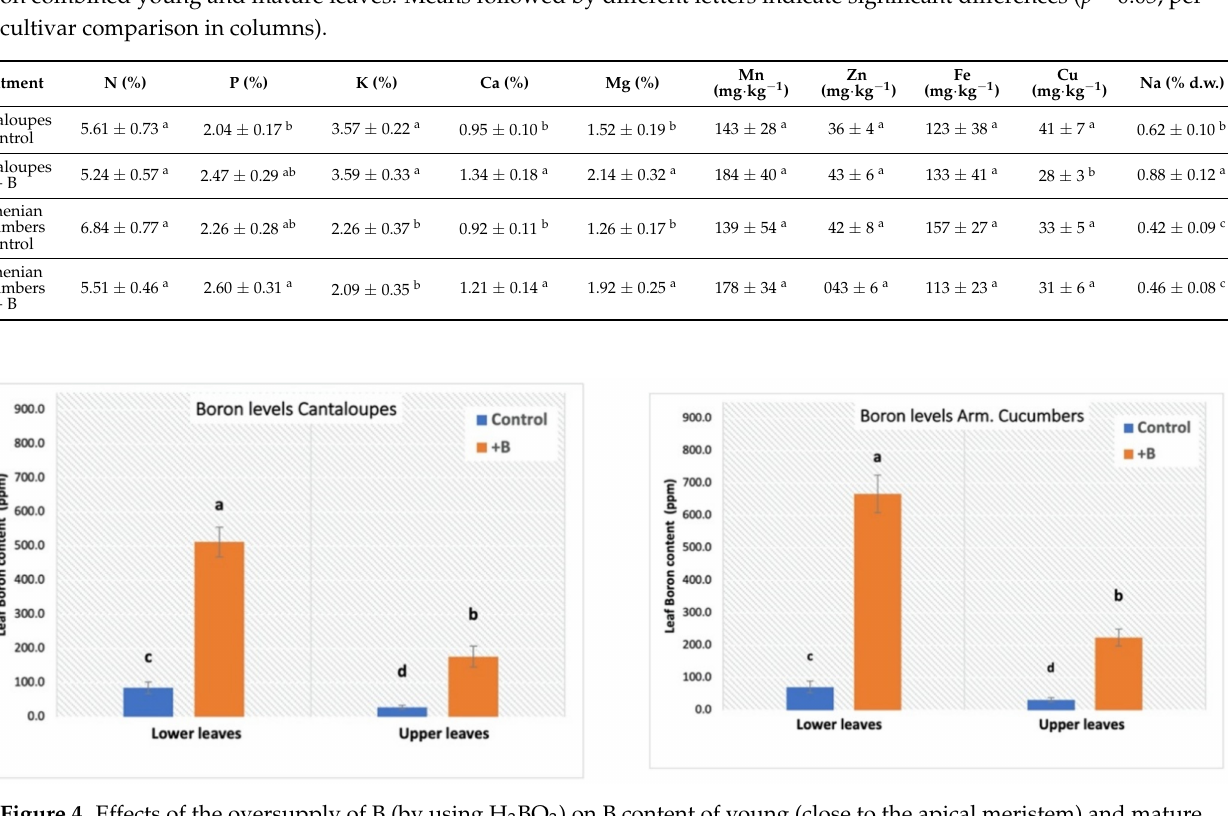
Figure 4. Effects of the oversupply of B (by using H 3 BO 3 ) on B content of young (close to the apical meristem) and mature (close to the root-to-shoot intersection) leaves of cantaloupes ( C. melo var. Cantalupensis cv. Retato Degli Ortolani) and Armenian cucumbers ( C. melo var. flexuosus cv. Abruzzese Tortarello). Growth period lasted 35 d, where no visible B toxicity symptoms were apparent (Figure 1). Means followed by different letters indicate significant differences ( p = 0.05). Values are the mean of ten replications ( ±